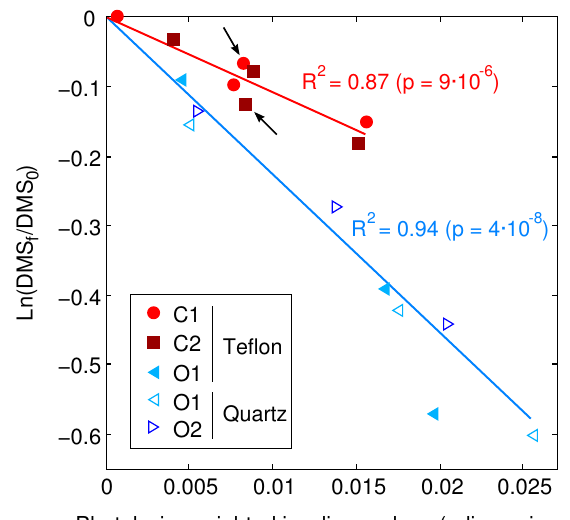
Fig. 3. DMS photolysis in fixed and vertically moving incubations. The two types of incubation showed consistent dose-response be- havior. Filled symbols: Teflon bottles incubated in C1 and C2 at three fixed depths and in a vertically moving basket (marked by ar- rows). Empty symbols: Teflon or quartz flasks incubated on board and withdrawn at different times (samples taken on three different days during the SUMMER-I cruise). The slope of the regression lines is k ∗ photo : the apparent quantum yield of DMS photolysis with respect to weighted spectral UV irradiance normalized to 300nm (as defined by Galí et al., 2013a). k ∗ photo was 10.8 and 23.9 at the coastal station and at the oceanic station,